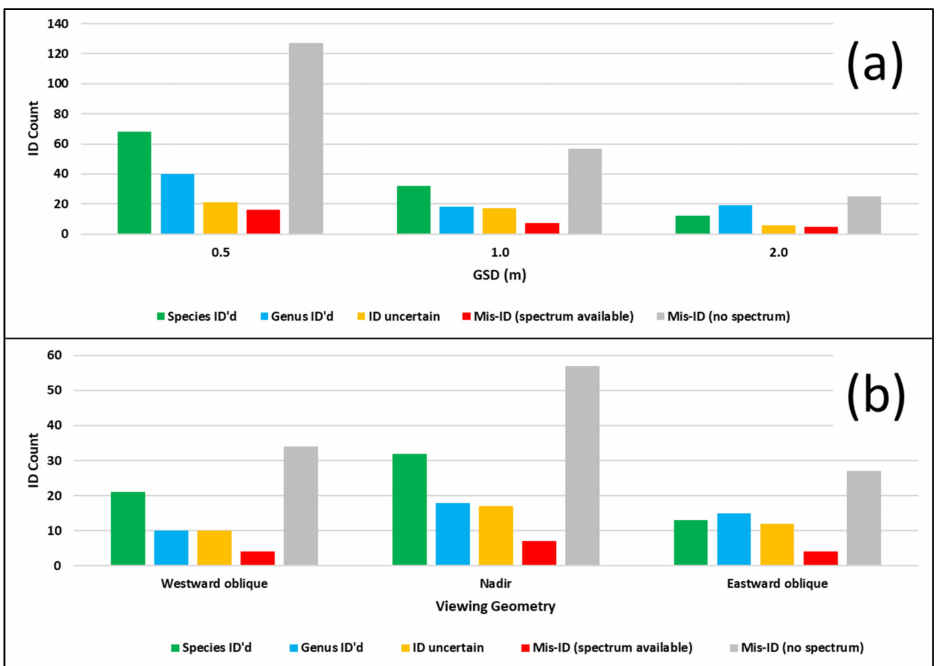
Figure 3. ( a ) Dependence of ID on flight altitude (GSD) for nominally nadir viewing, ( b ) dependence of ID on viewing geometry at a nominal 1-m